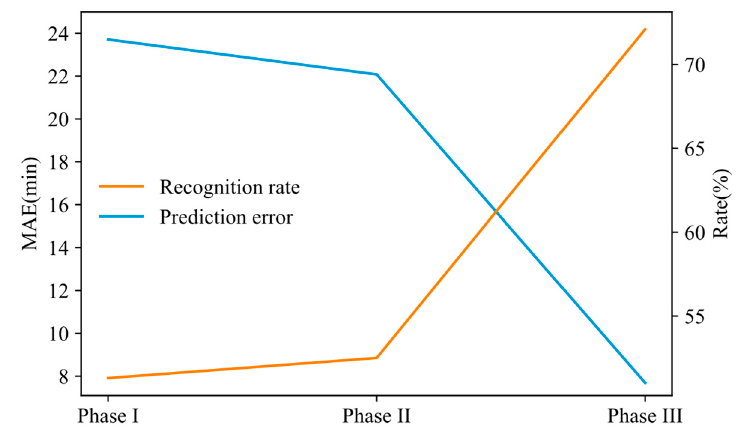
Figure 9. Remaining time use prediction error and delayed flight identification rate.